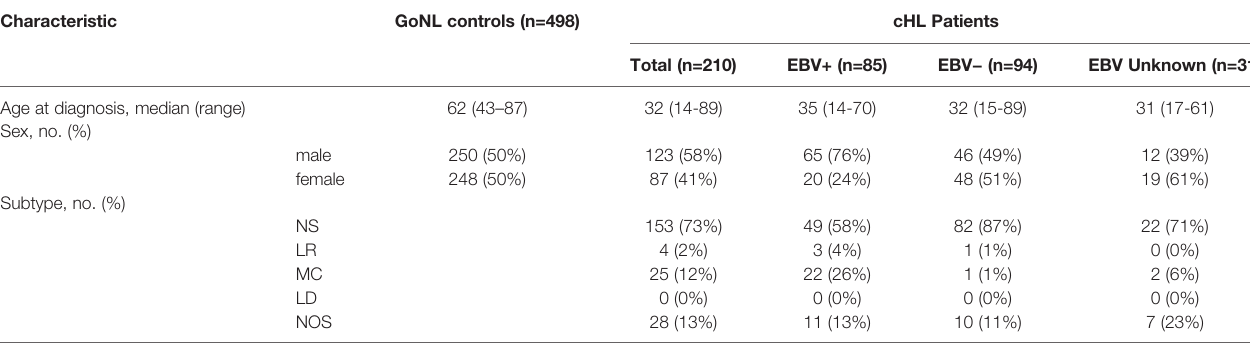
TABLE 1 | Characteristics of controls and